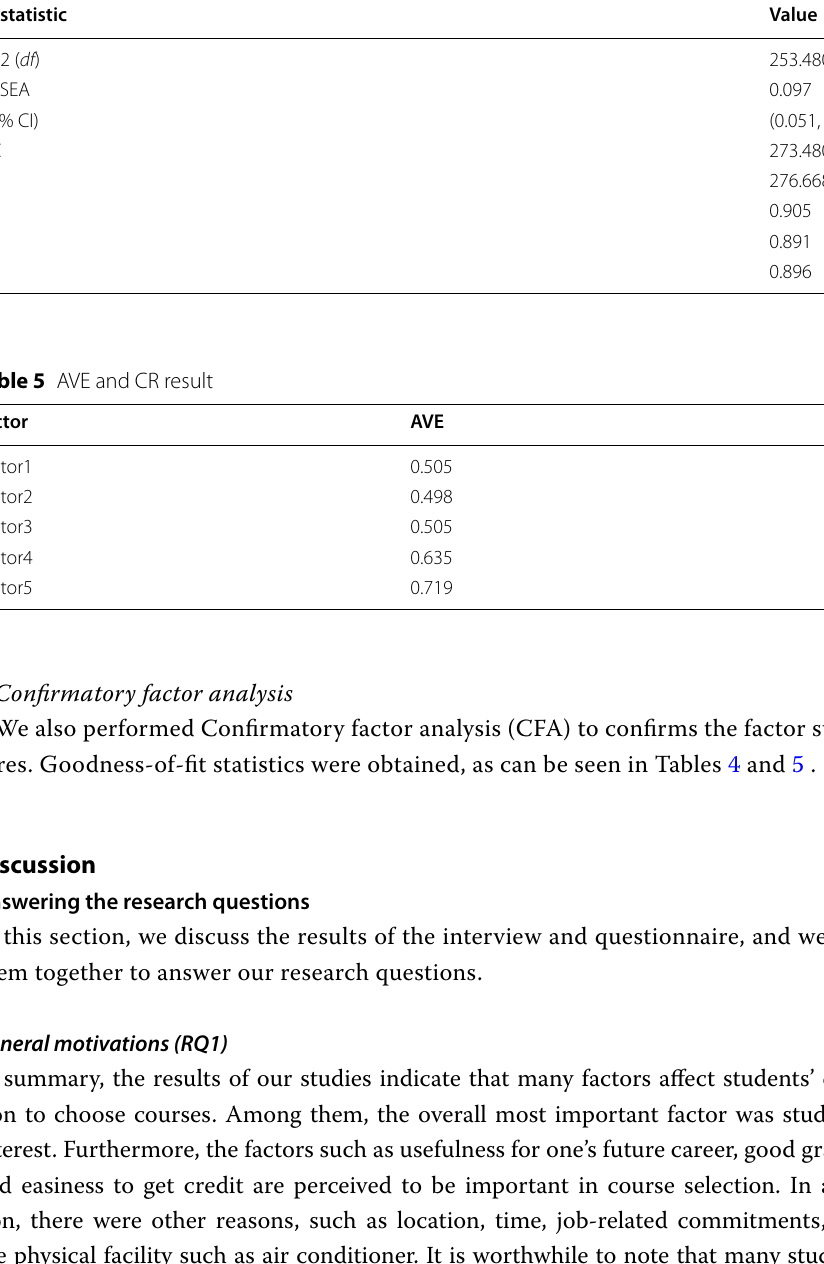
Table 4 Model fit summary